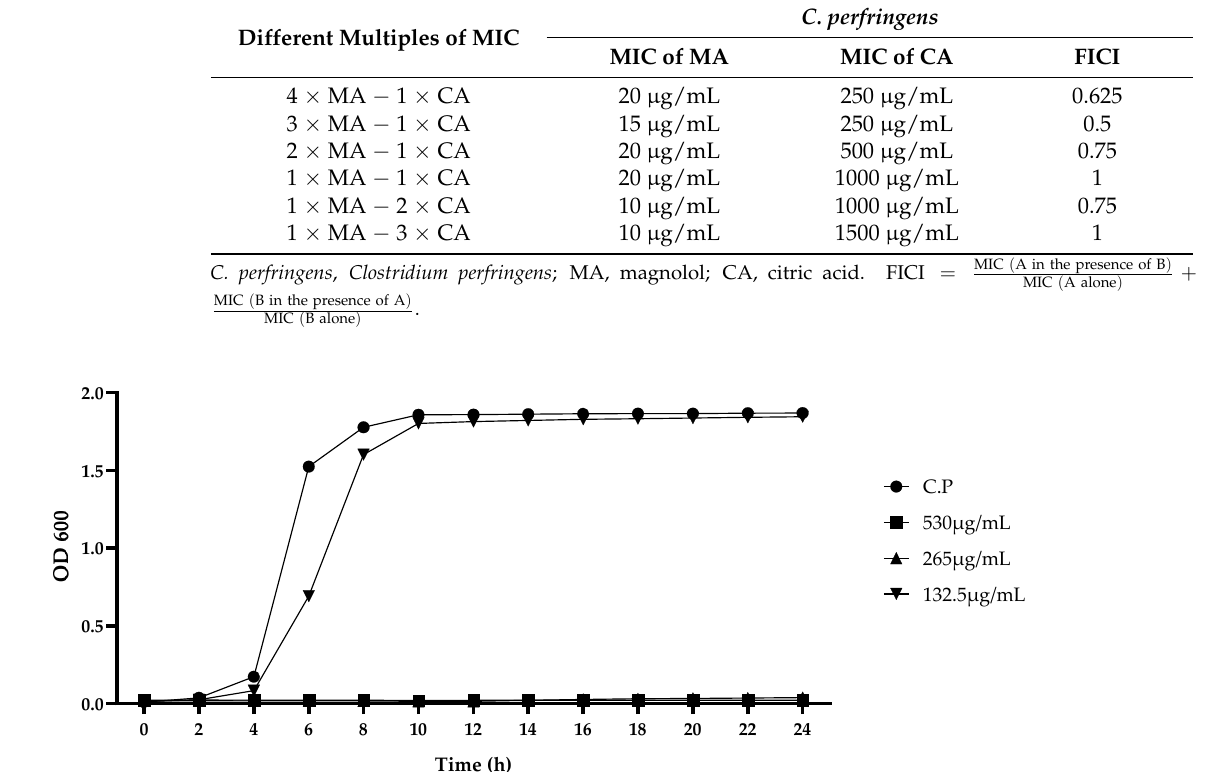
Figure 1. Growth curve of C. perfringens at different concentrations. C. perfringens represents the blank control.